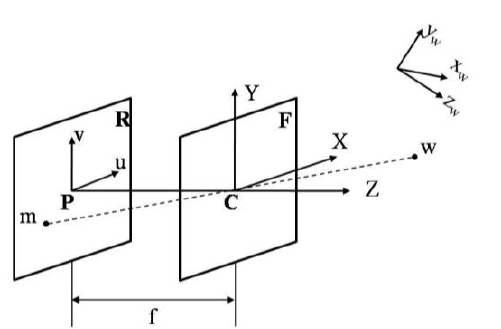
Figure 4. The pinhole camera